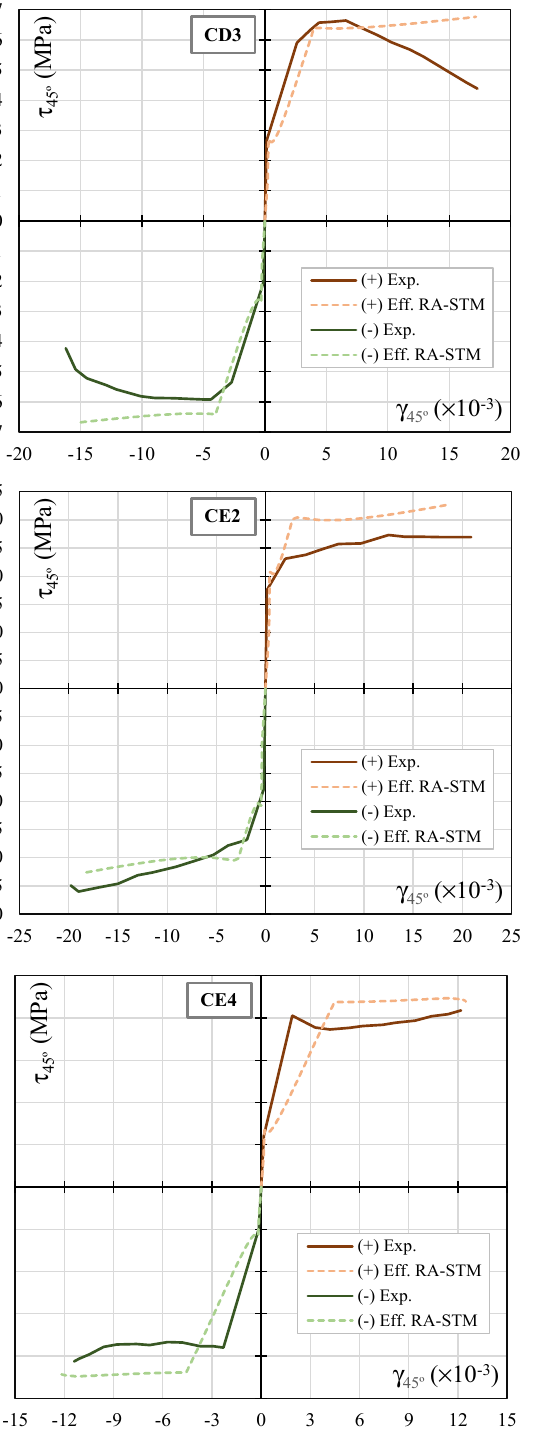
Figure 7. Envelope τ 45 ◦ – γ 45 ◦ curves for the reference RC panels (CD3, CD4, CE2, CE3, CE4 and γ − Figure 7. Envelope curves for the reference RC panels (CD3, CD4, CE2, CE3, CE4 and CF2). ° ° 45